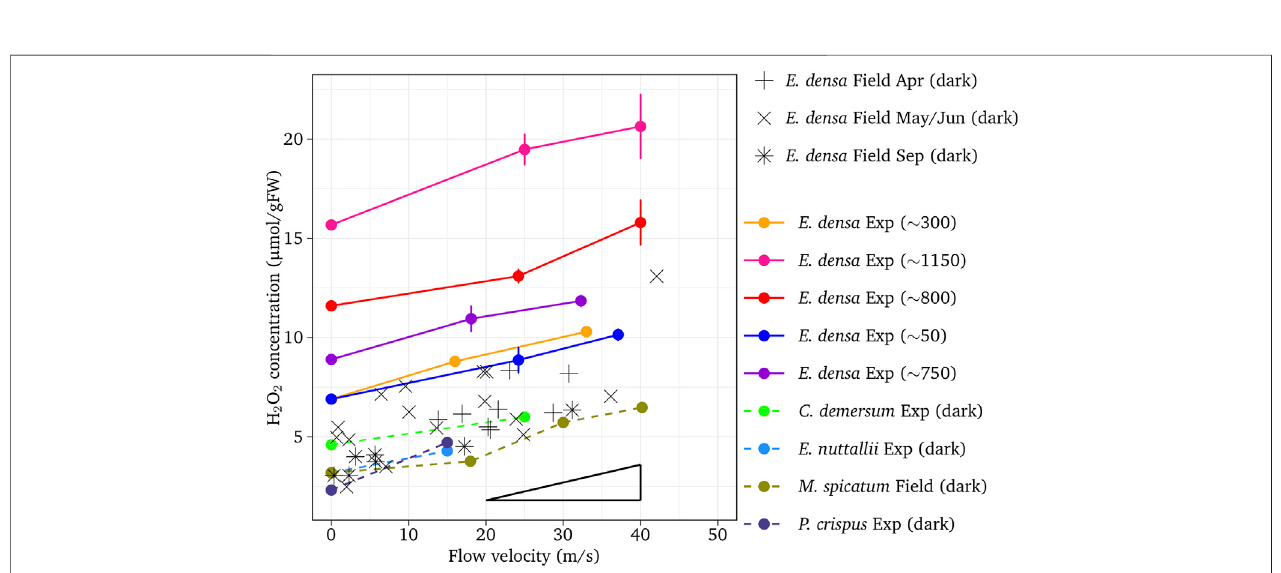
FIGURE 1 | Effect of temperature on H 2 O 2 concentration at different light intensities in native aquatic macrophytes ( M. spicatum , C. demersum , and P. crispuss ) and invasive species ( E. densa and E. nuttallii ). Vertical bars indicate the standard deviation. The values in parentheses are light intensities (µmol/m 2 /s).